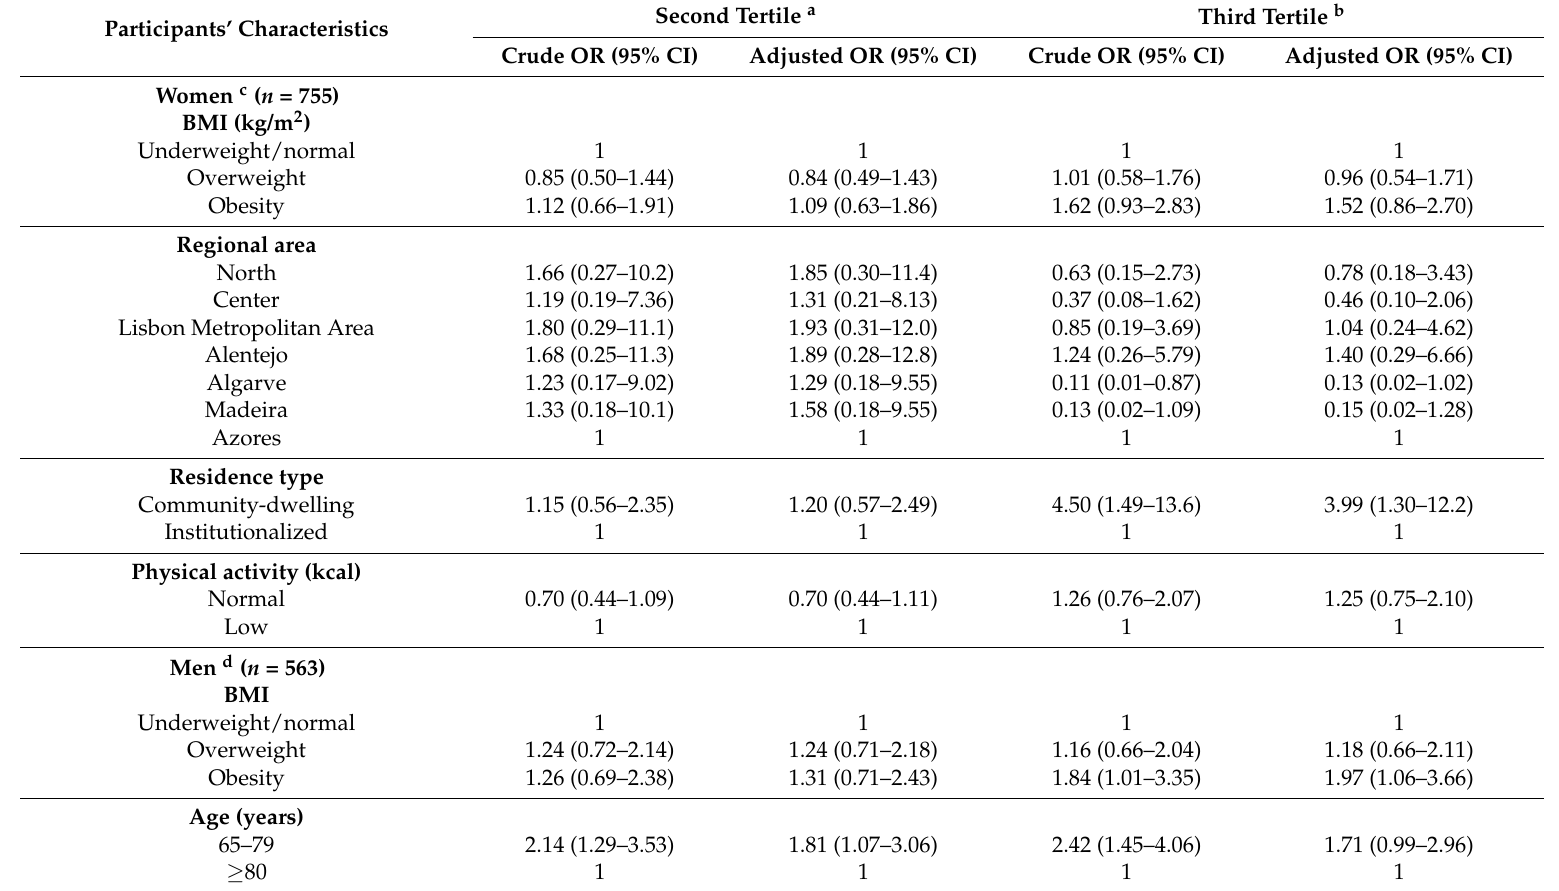
Table 3. Multinomial logistic regression results for the association between tertiles of osmolality (mOsm) and body mass index (kg/m 2 ) for 1318 Portuguese older adults, ≥ 65 years old, participating in a cross-sectional observational